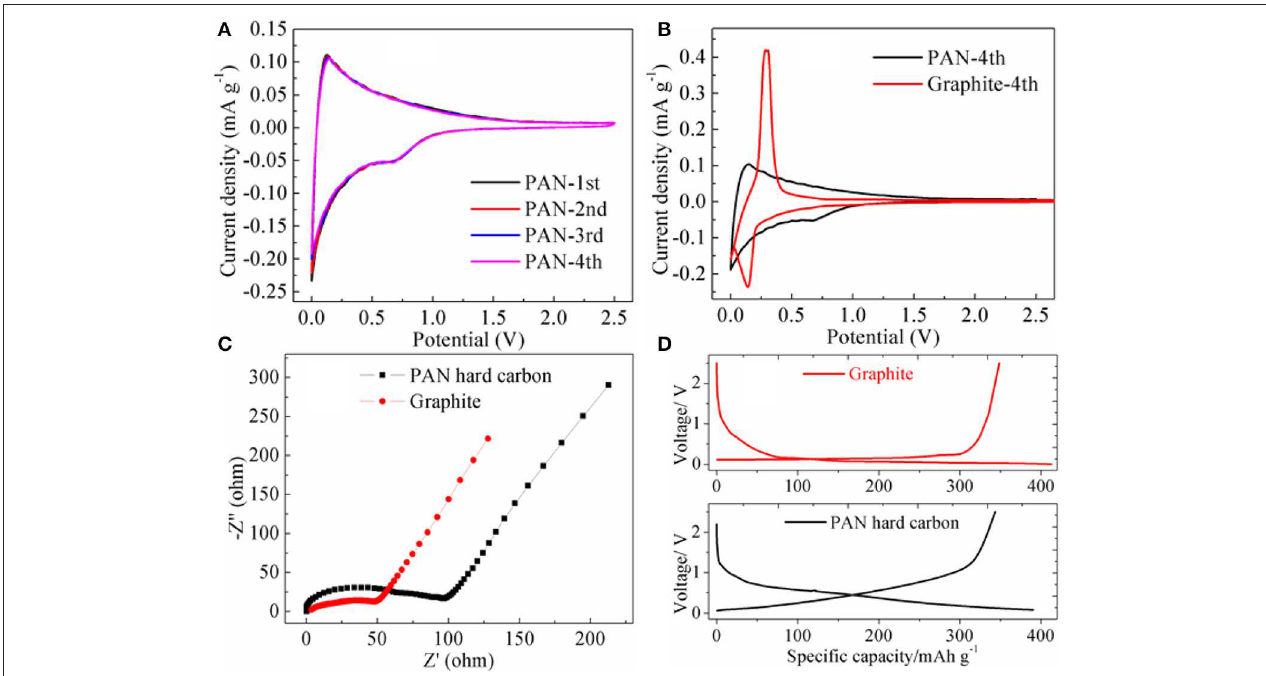
FIGURE 3 | (A) Cyclic voltammetry curves of PAN hard carbon electrode; (B) the 4th CV curve comparison of PAN hard carbon and graphite electrodes; (C) EIS spectra of PAN hard carbon and graphite electrodes; (D) Initial charging/discharging curves of PAN hard carbon and graphite